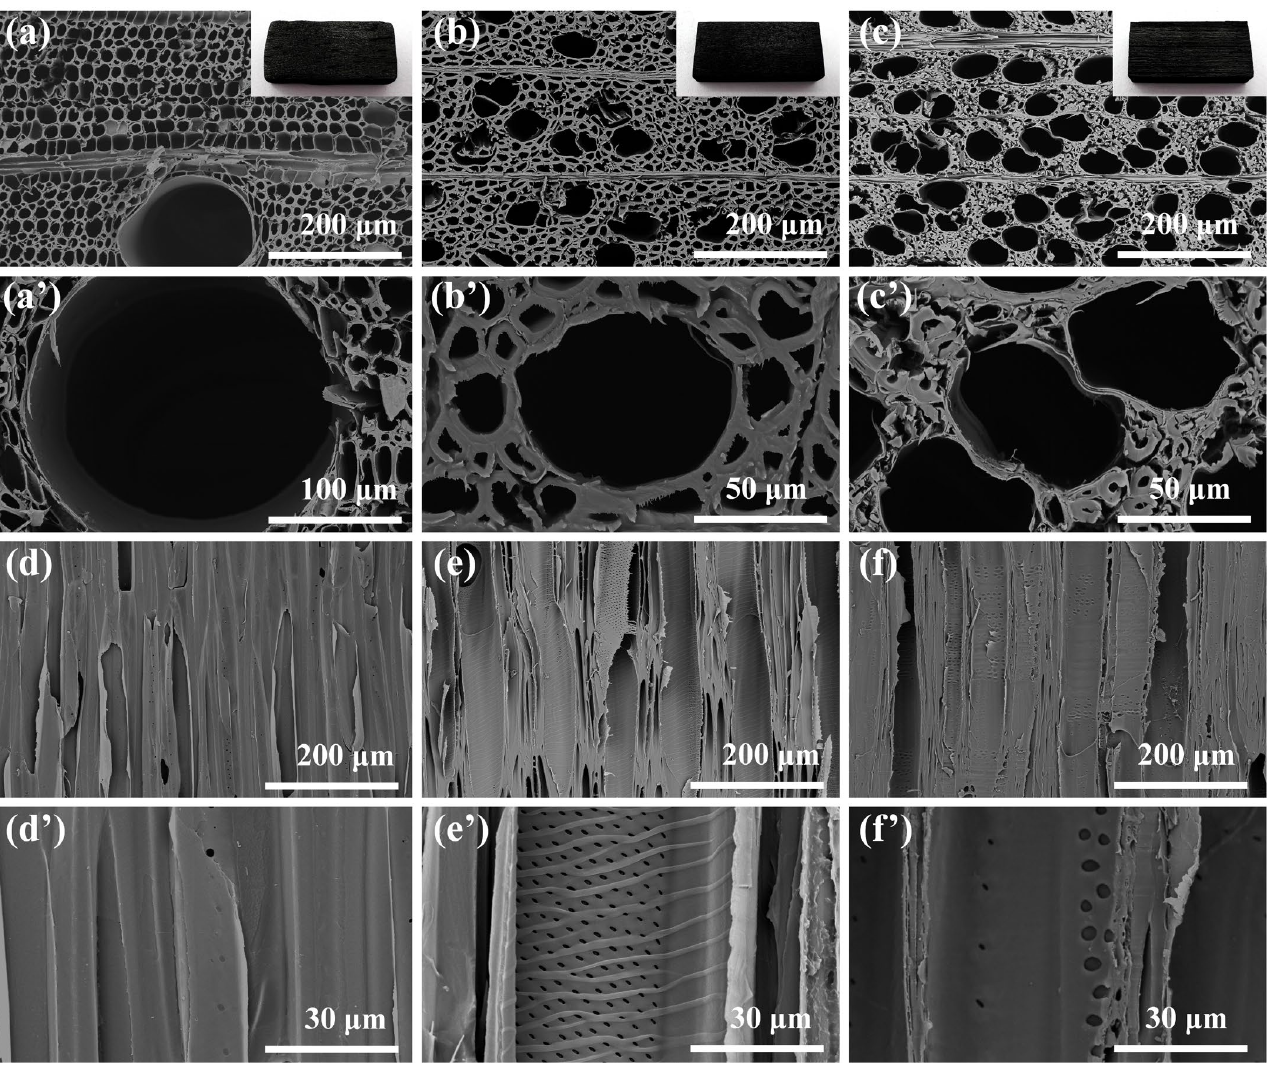
Figure 2. SEM images and pictures of balsa wood-derived carbon ( a , a’ ), basswood-derived carbon ( b , b’ ) and beech-derived carbon ( c , c’ ) in the cross-section, and SEM images of balsa wood-derived carbon ( d , d’ ), basswood-derived carbon ( e , e’ ) and beech-derived carbon ( f , f’ ) in the vertical-section. The XRD spectra of three wood-derived carbon samples are shown in the Figure 3a.